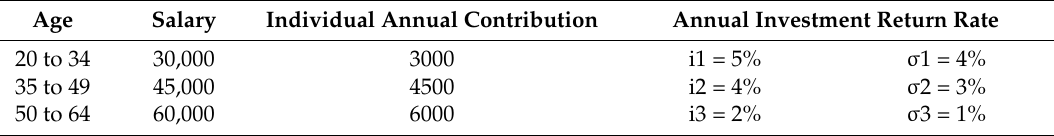
Table 1. Contributions by age